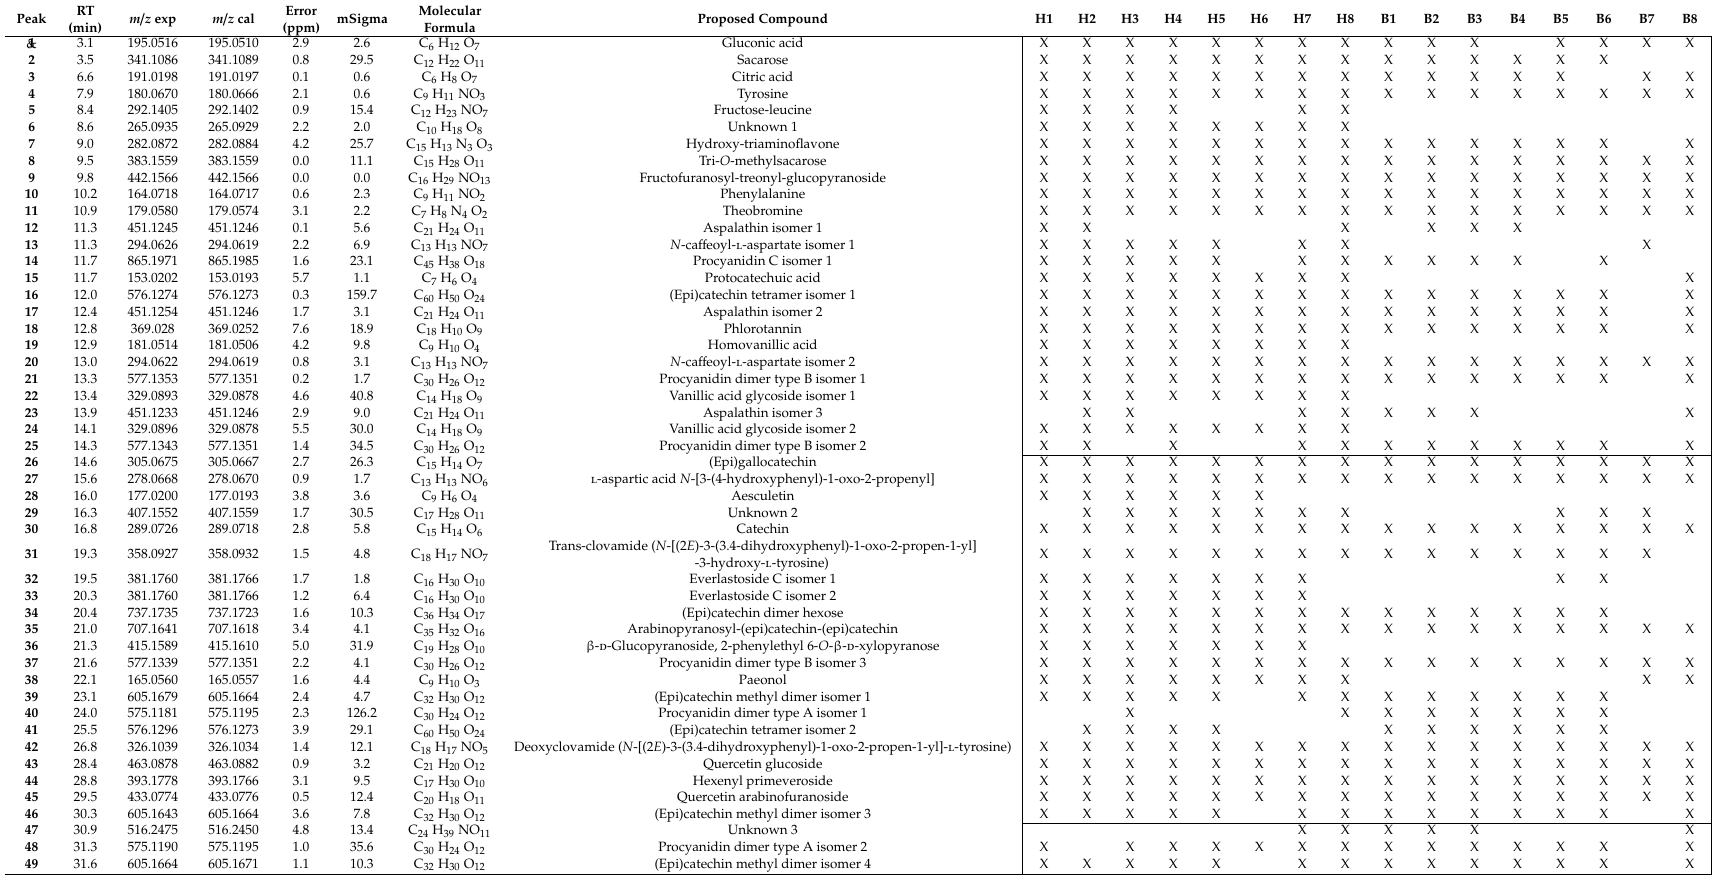
Table 1. Chemical characterization of compounds detected in husk and bean cocoa extracts by